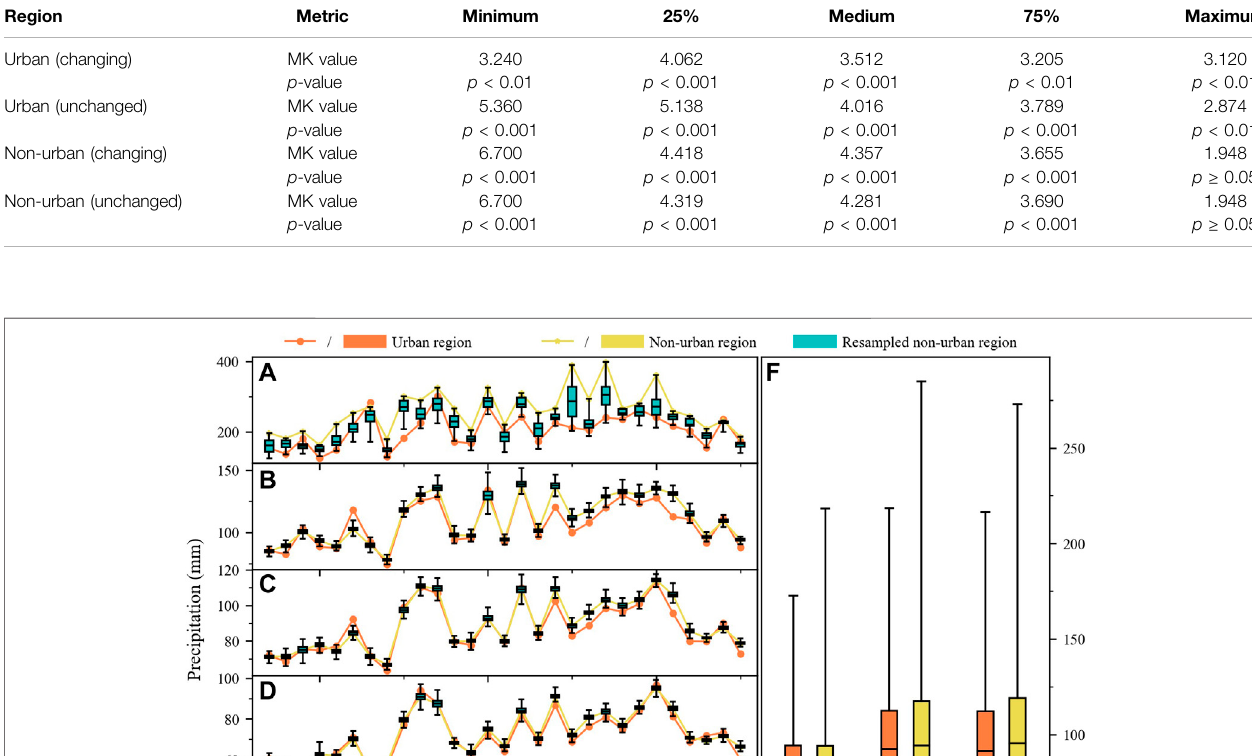
TABLE 2 | The MK trend test for annual MDP in different percentiles of the YDM from 1992 to 2020. Region